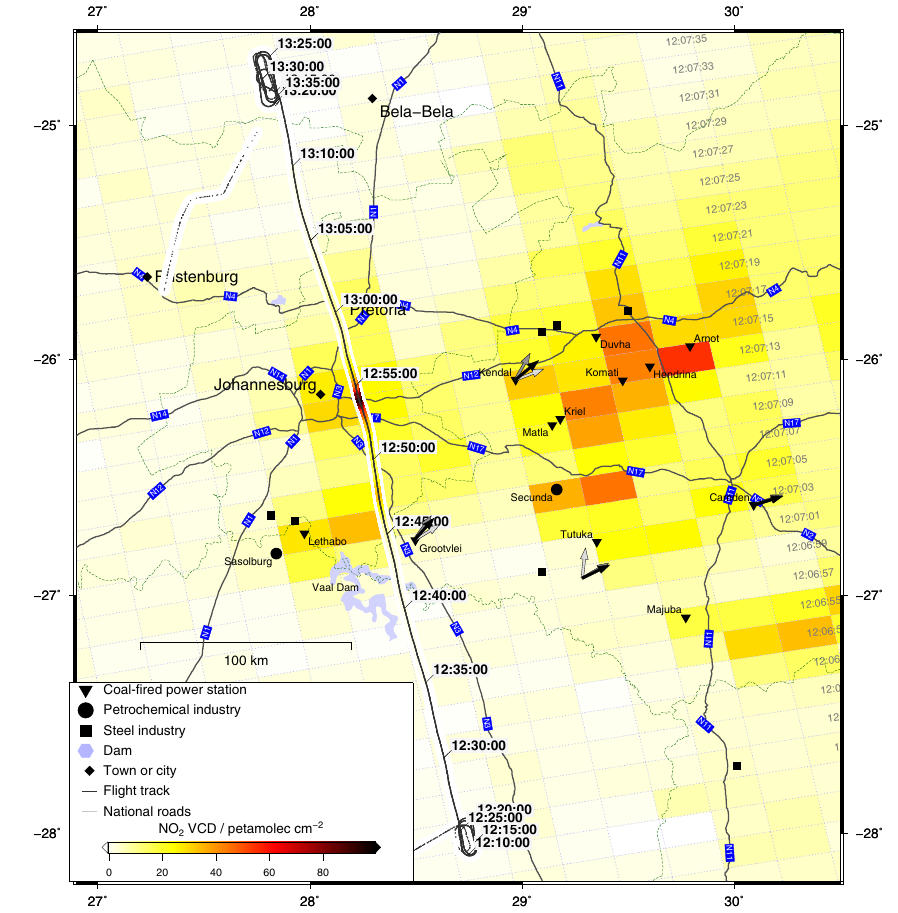
Figure 9. A comparison of the 10s moving average airborne DOAS NO 2 vertical column densities (indicated by colour along the flight track) with OMI DOMINO V2.0 (coloured rectangles) on 9 August 2007. UTC aircraft time is indicated every 5min along the flight track (black line running from approximately 28 ◦ S, 28.8 ◦ E to 24.8 ◦ S, 27.8 ◦ E). UTC satellite time is shown for each row. Hourly average wind directions for several weather stations are shown for the hours up to 13:00UTC (black arrow), 12:00UTC (dark grey arrow) and 11:00UTC (light grey